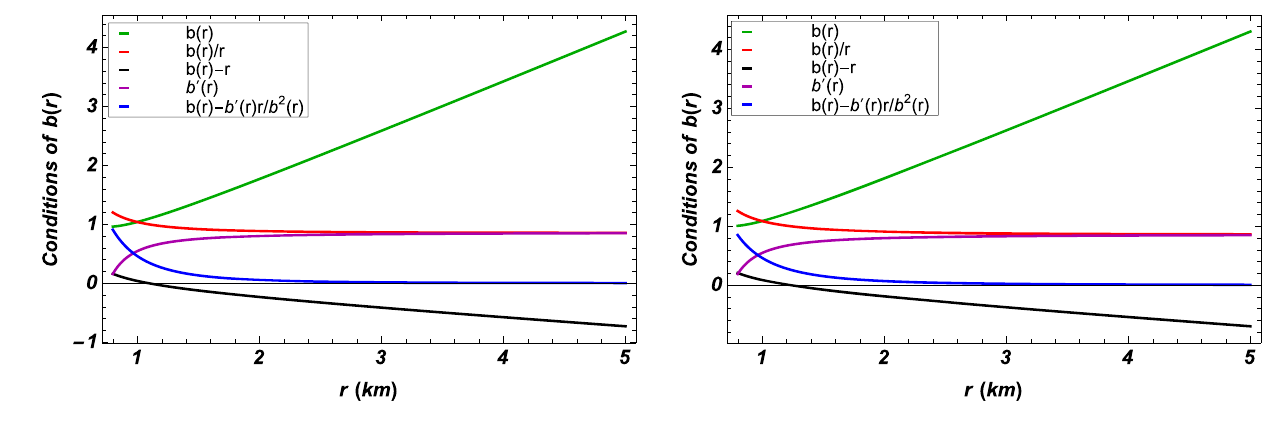
Fig. 1 Wormhole properties for Model-I (left) and Model-II (Right)